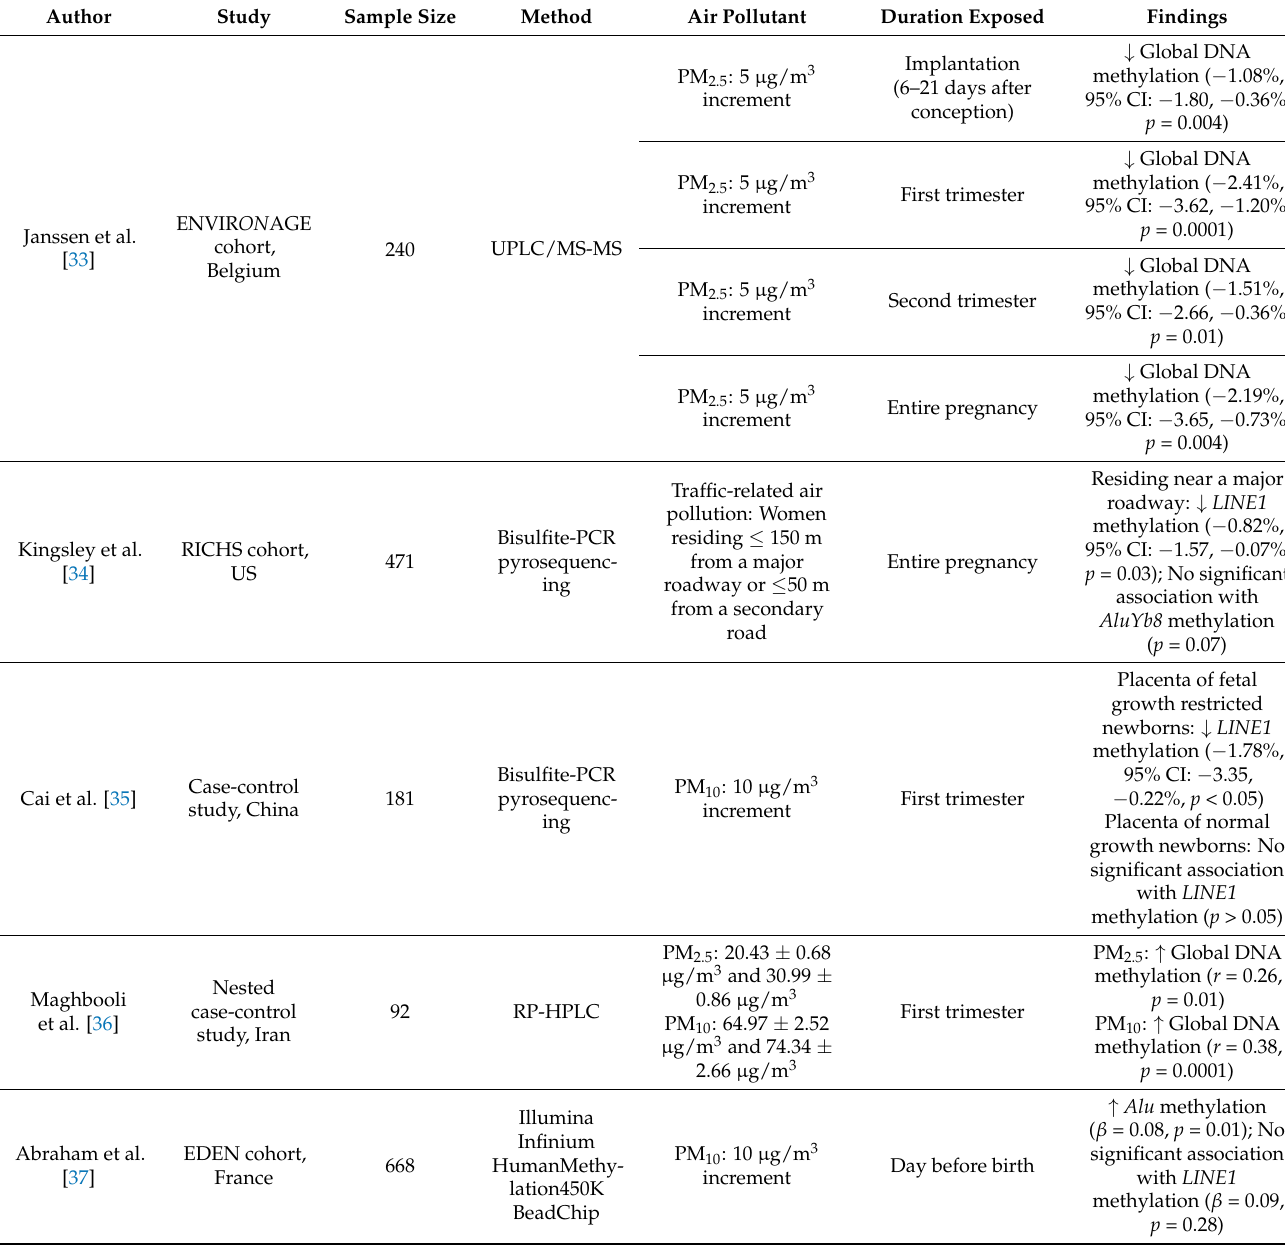
Table 1. Studies on prenatal air pollution exposure and placental global DNA